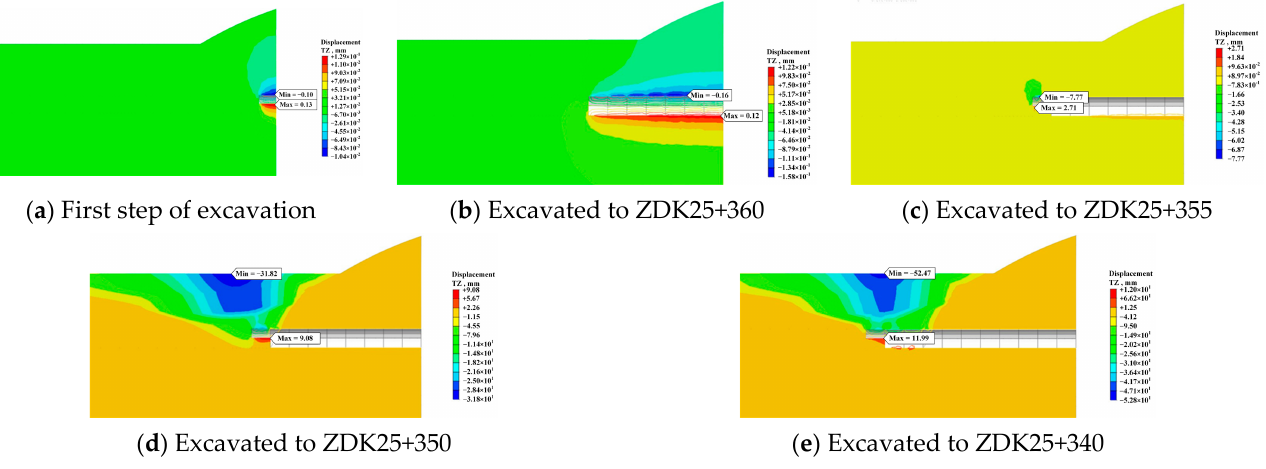
Figure 10. Settlement of the ground.